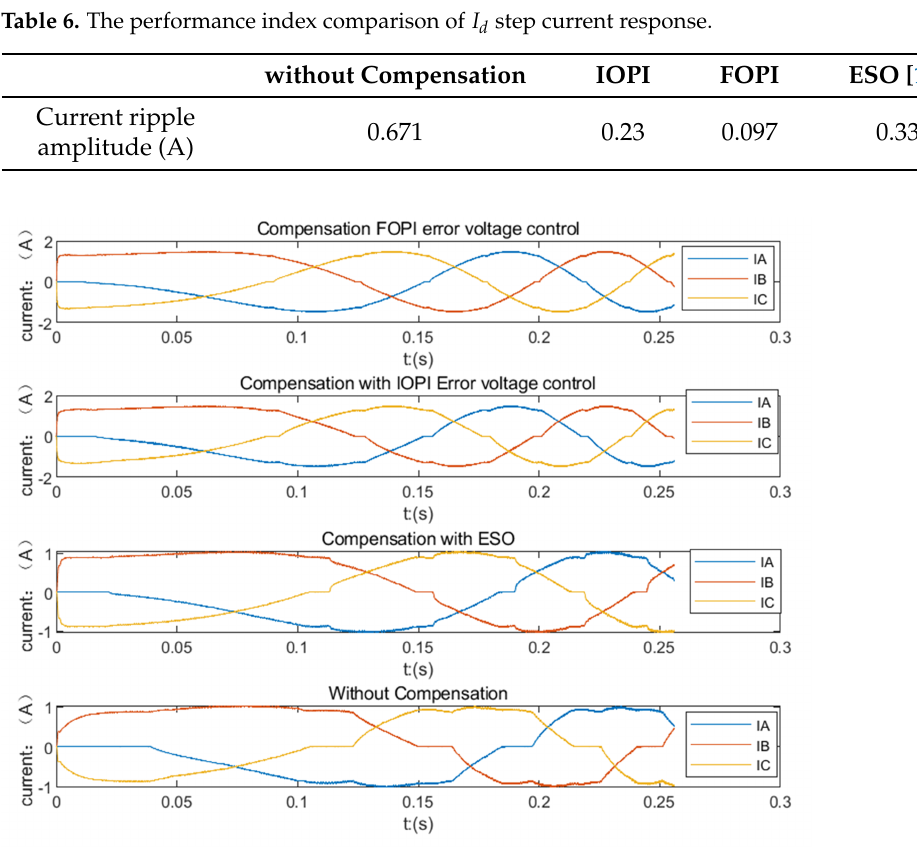
Figure 15. Comparison of three-phase current response of three control strategies. Table 7. The performance index comparison of three-phrase current step current